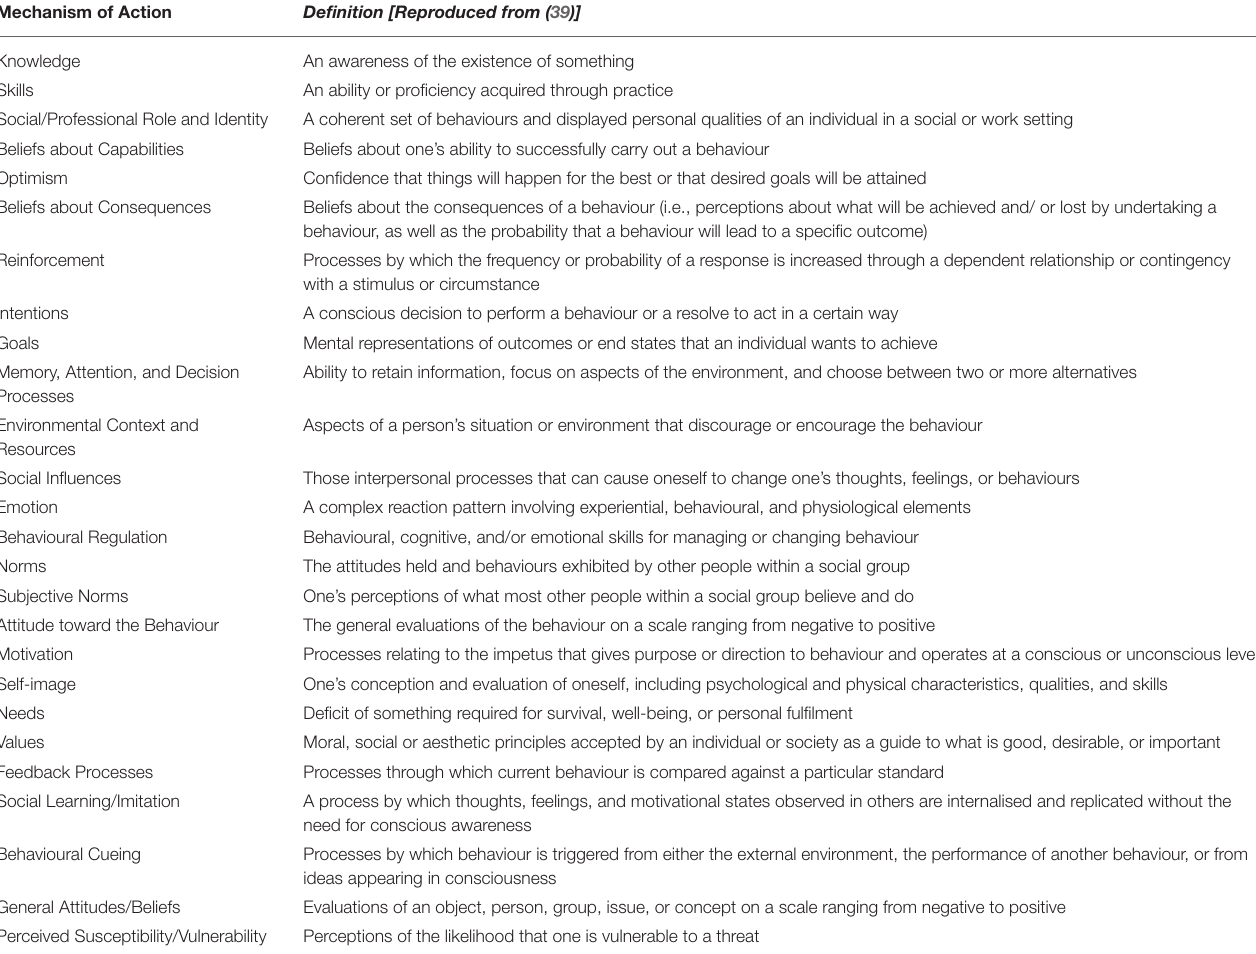
TABLE 3 | Mechanisms of action and their